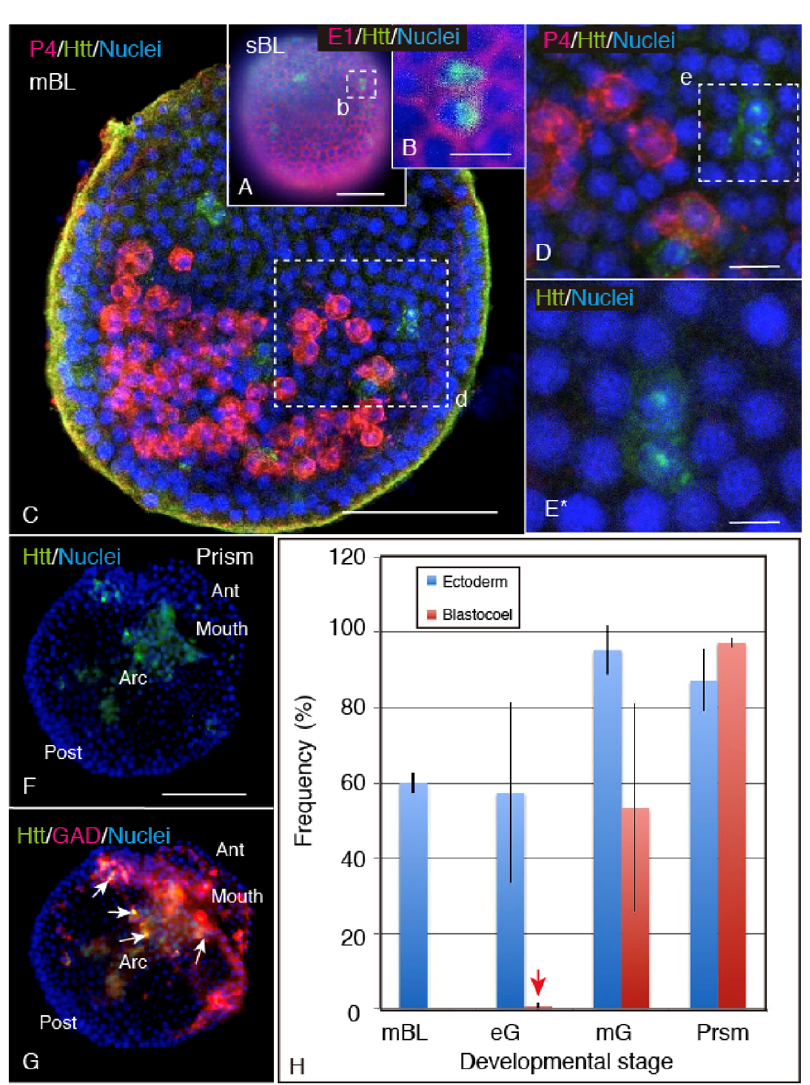
Figure 2. Fluorescent ( A , B ) and Confocal microscopic images ( C – G ) of Hp-Htt expressing cells and primary mesenchyme cells from the sBL stage to the pL stage. ( A ) Swimming blastula with an Hp-Htt-positive signal (green) in the Epith-2-positive ectoderm (red). ( B ) A higher magnification image of a region shown by the rectangle (b) in ( A ) shows an Hp-Htt-positive region in the nuclei of the ectoderm. ( C ) Confocal microscopy of mBL showing primary mesenchyme cells (PMC, red) that have invaginated into the blastocoel and the Hp-Htt-positive cells in the ectoderm (green). ( D ) Higher magnification image of the ectoderm indicated with a rectangle (d) in ( C ). ( E* ) Higher magnification of the cytoplasmic Hp-Htt-positive dots shown by a squire (e) in ( D ) shows the signal in the nuclei (blue) and the cytoplasm near the nucleus. Supplemental animation (Figure S2E*) shows a regional difference between the Hp-Htt-positive nuclear spot and the blurred Hp-Htt-positive area around the nuclei. ( F ) Ventral view of a late pL by fluorescent microscopy depicts the Hp-Htt- positive blastocoelar cells (green) around the archenteron (Arc) and the mouth opening (Mouth). Ant: Anterior, Post: Posterior. ( G ) A triple-stained image of ( F ) shows the Hp-Htt-positive signal (green) in the GAD-positive (red) cells (arrows). ( H ) Statistical analysis of spatiotemporal Hp-Htt- positive signal spreading from the ectodermal cells (blue columns) to the blastocoelar cells (red columns) during development from the mBL stage to the pL stage (Prsm). eG: early gastrula stage, mG; mid-gastrula stage. Red arrow; a tiny proportion of Hp-Htt-positive blastocoelar cells in eG. Scale bars = 50 µ m ( A , C , F ), 15 µ m ( B ), 10 µ m ( D ), 5 µ m ( E *). ( D ) and ( E *): Refer to Supplemental Figure S2E.